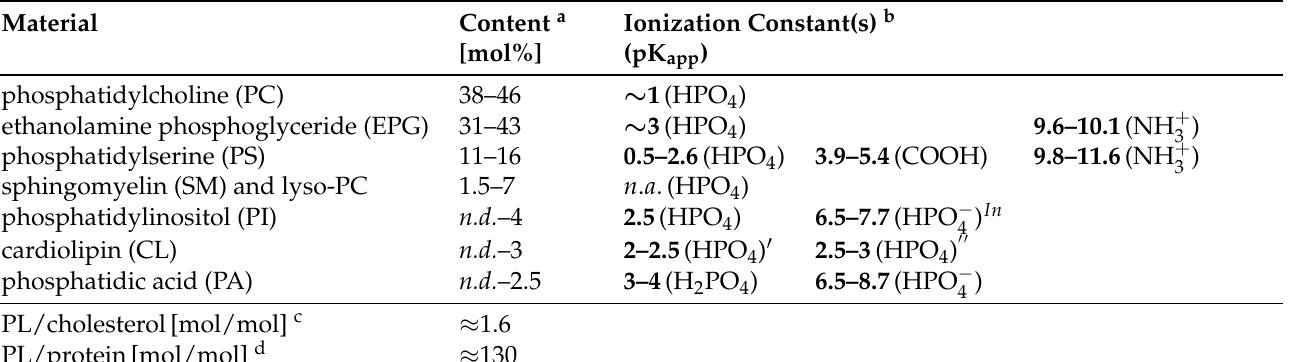
Table 1. Material composition of AChR-rich membranes from Torpedo californica and T. marmorata as well as apparent ionization constants of phospholipids (PL) as determined with protein-free lipid membranes in salt